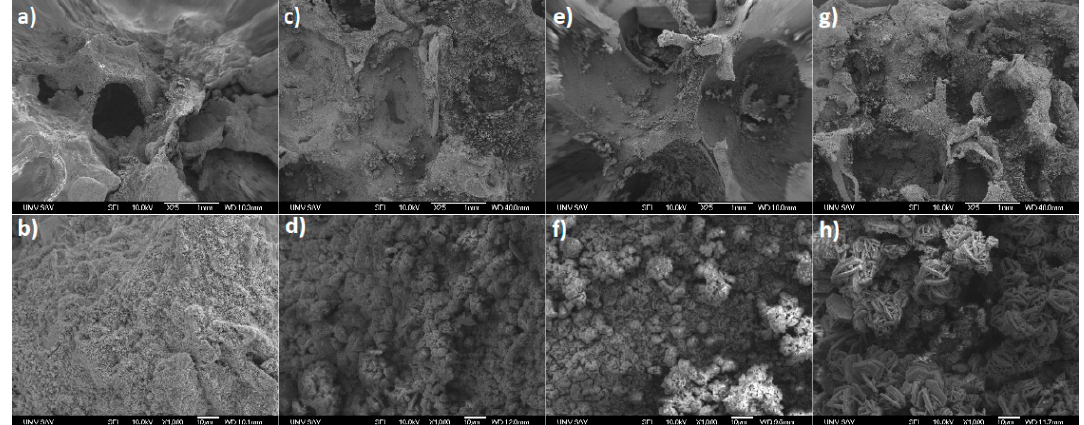
Figure 7. SEM micrographs of sintered iron samples after 8 weeks of corrosion in Hanks’ solution: Fe sample without PEG ( a , b ); Fe-PEG1, 0.8 wt. % PEG ( c , d ); Fe-PEG2, 1.5 wt. % PEG ( e , f ); and Fe-PEG3, 3.0 wt. % PEG ( g , h ). Detail of the surfaces above at a higher magnification ( b , d , f , h ).